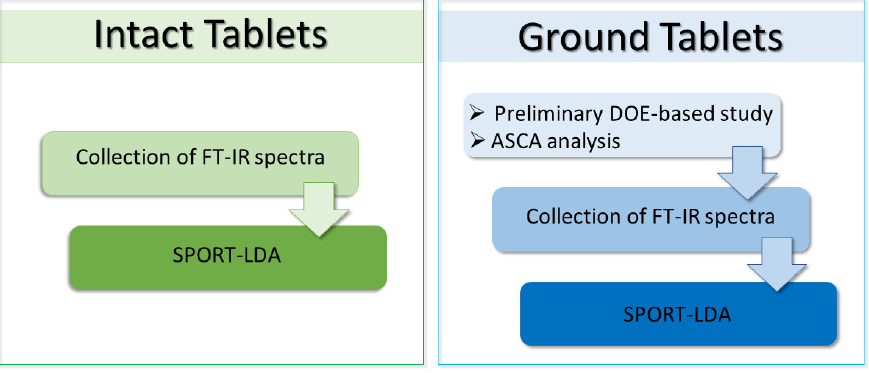
Figure 1. Chemometric workflow.